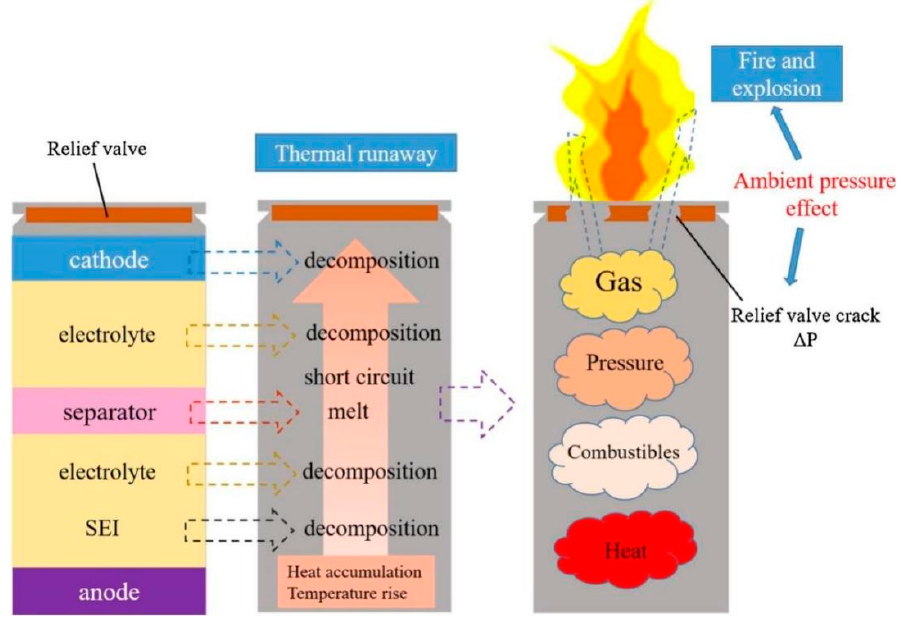
Figure 4. The shock pressure caused by the ejected gas [79].